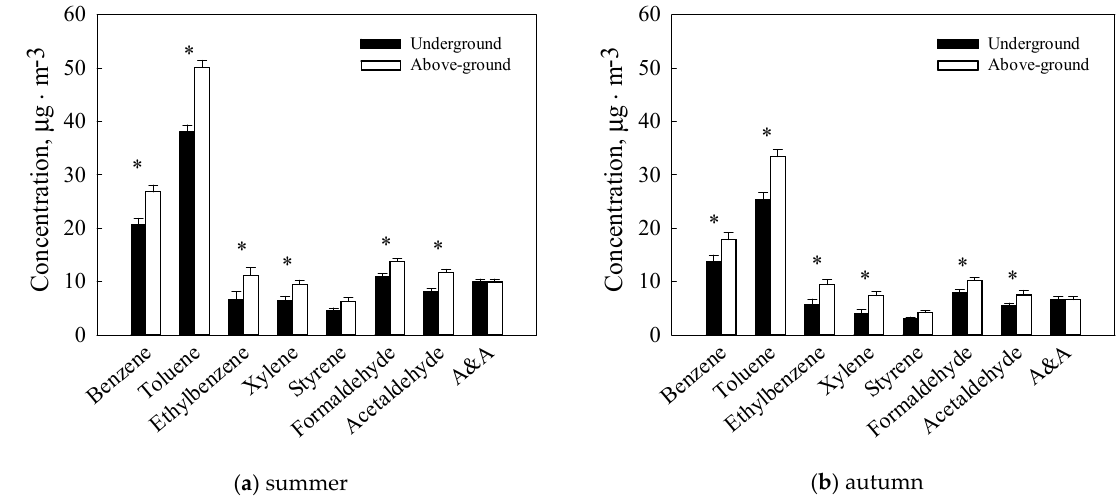
Figure 2. The 2015–2016 averaged VOC concentrations in metro carriages under above-ground and underground track during ( a ) summer and ( b ) autumn. The error bar indicates the standard deviation for four replicates. “*” indicates the difference between the average VOCs value under the above-ground track and underground track conditions (P < 0.05). A&A: Acetone and Acrolein. 2015 data is from Ref. [35].